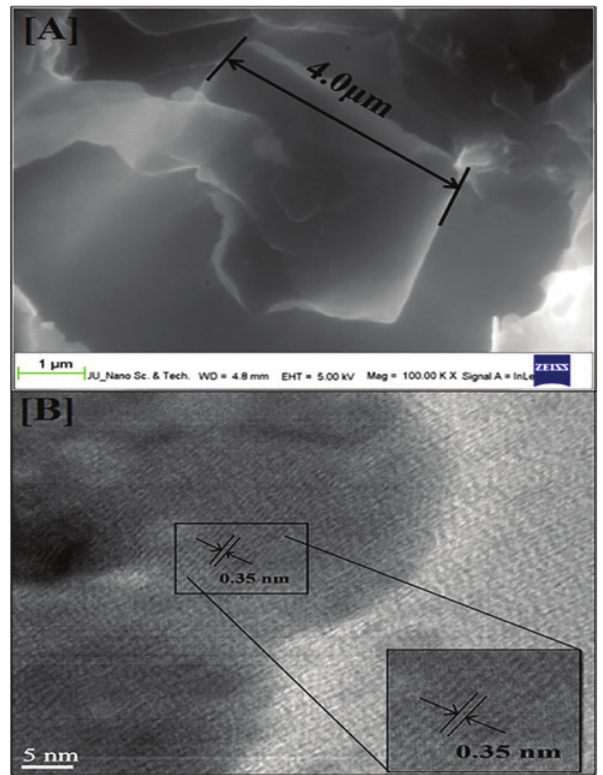
Figure 6: FESEM and TEM analysis. (A) FESEM and (B) TEM images of electrochemically exfoliated graphene